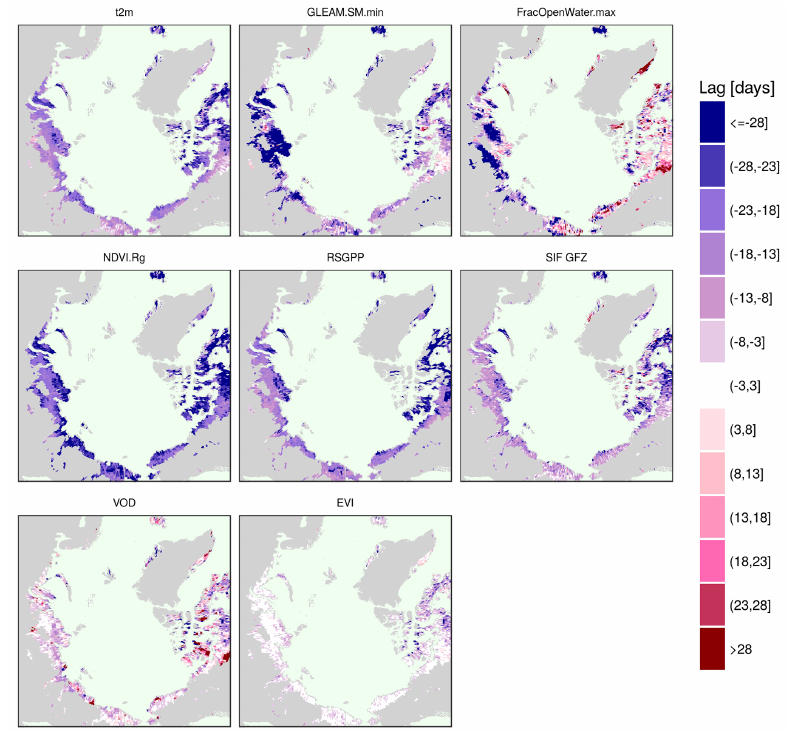
Figure 6. Average time difference of the maximum across years of selected vegetation proxies and the NDVI.